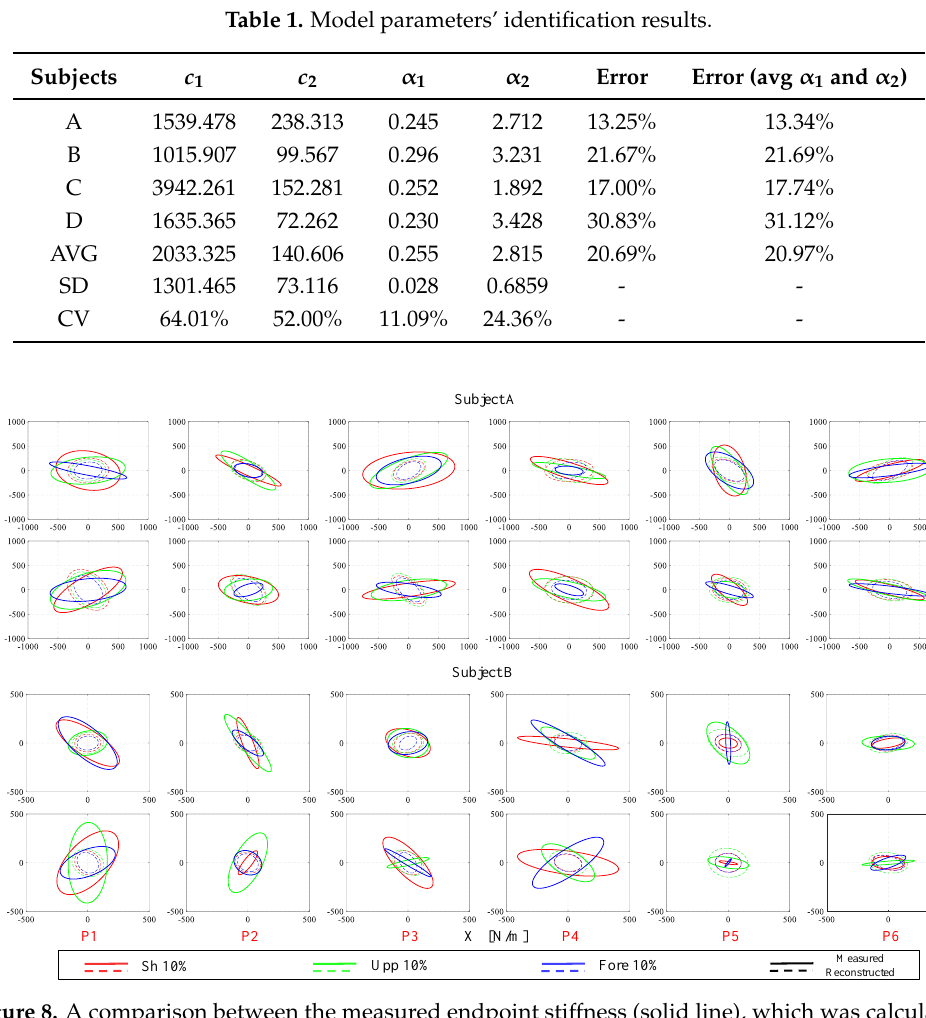
Figure 8. A comparison between the measured endpoint stiffness (solid line), which was calculated from the displacement profile and the reaction forces in the perturbation experiment, and the predicted one (dashed line), which was estimated by our model for subjects A and B (typical results across subjects) at different arm configurations and muscle activation states. P# represents different positions; the different colors in the subplot represent different muscle activation states, as shown in the bottom